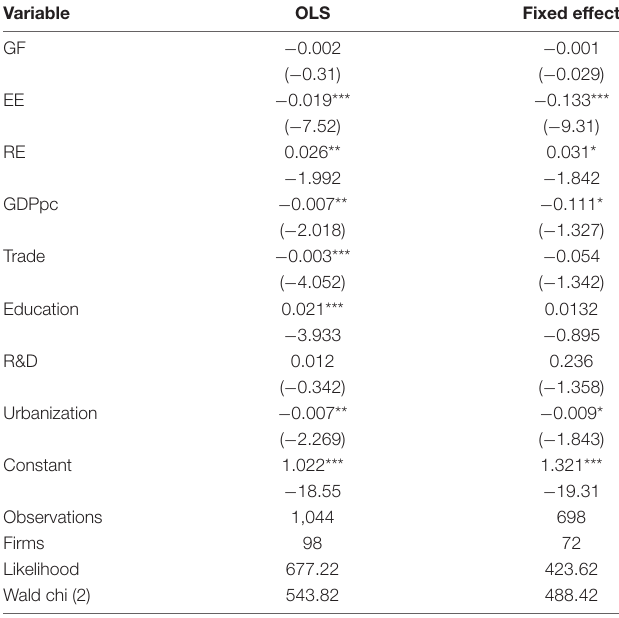
TABLE 3 | Results of fixed-effects regressions.